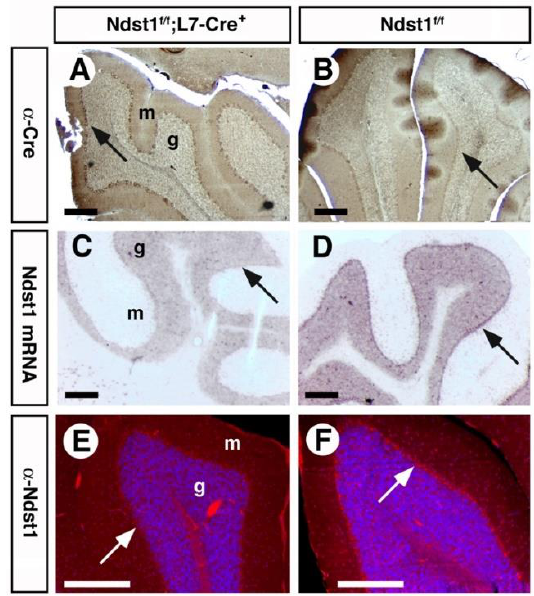
Figure 2. Ndst1 mRNA and protein expression is abolished in Cre-expressing Purkinje cells of Ndst1 f/f ;L7-Cre + mice. ( A ) Immunohistochemical detection of Cre expression (brown stain) in adult cerebellar sections. Cre expression restricted to the Purkinje cell layer of L7-Cre + mice (arrow) but absent from mice carrying the floxed allele of Ndst1 ( B ). In situ hybridization employing an antisense probe directed against exon 2 of Ndst1 mRNA demonstrates loss of the floxed sequence in L7-Cre + transgenic mice (arrow) but not in Type 2 Ndst1 transgenes ( C,D ), and immunohistological detection of Ndst1 protein using the affinity-purified rabbit-anti-mouse Ndst1 antiserum demonstrates loss of the protein only in targeted cells of Ndst1 f / f ;L7-Cre + transgenic mice ( E , F , arrow). g: granule cell layer, m: molecular cell layer. Scale bars: 200 μm.